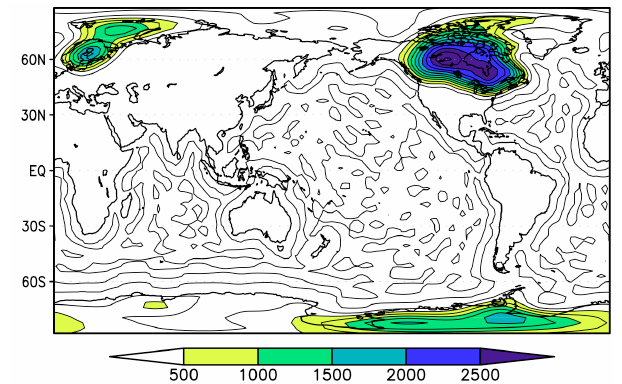
Fig. 9. The orography change for LGM-PI Figure 9. The orography change for LGM-PI (m). 4